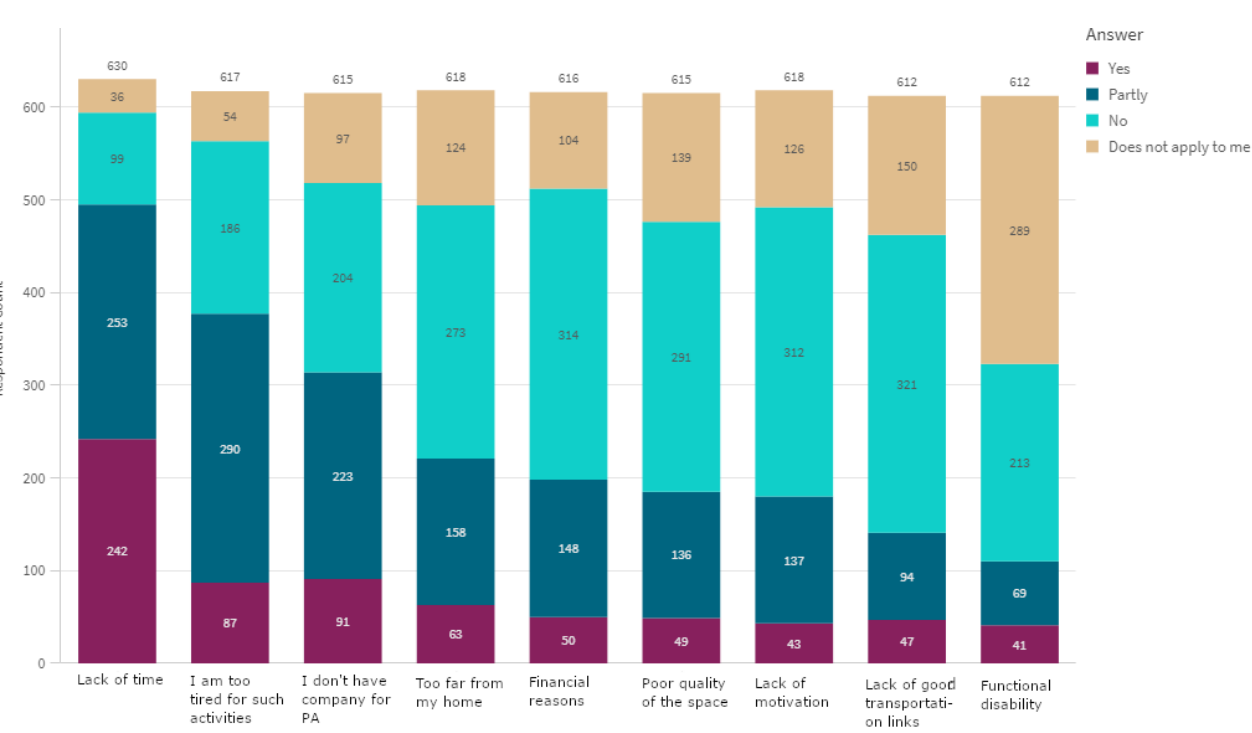
Figure 2. Reasons for Failing to Achieve Sufficient Physical Activity. Note: Missing values are excluded from the calculation.